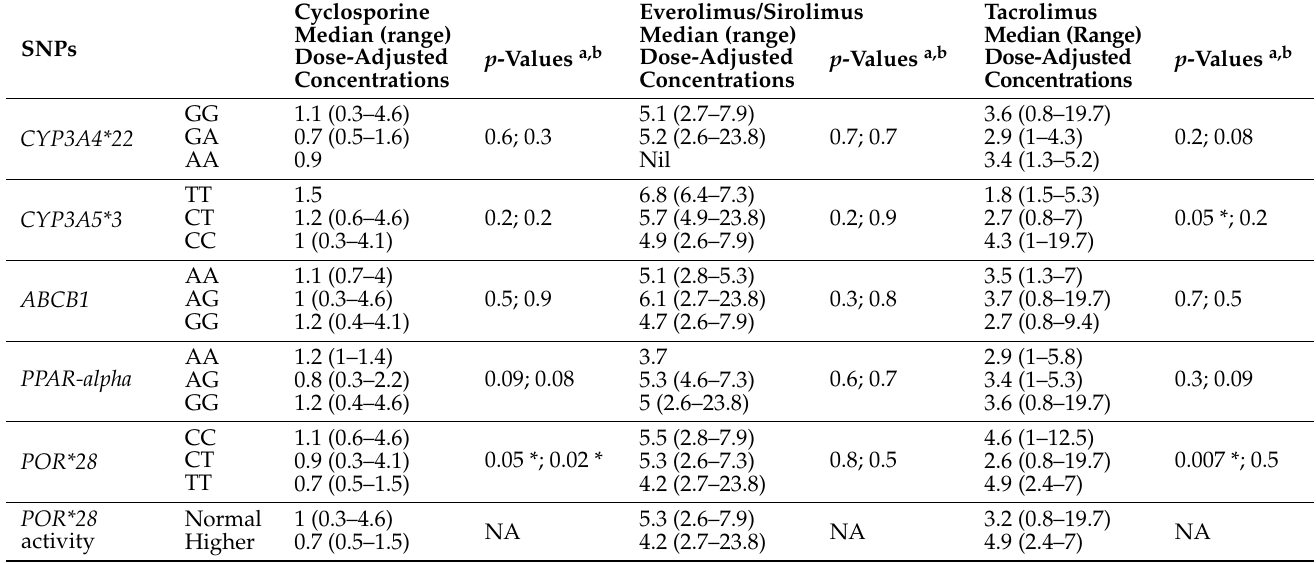
Table 6. Evaluation of dose-adjusted concentrations with SNPs.